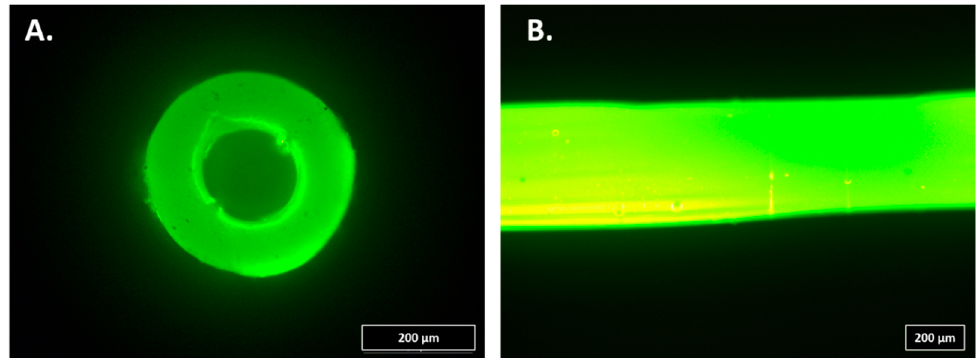
Figure 1. Fluorescence micrographs of a catheter intraluminally ( A ) or extraluminally ( B ) coated with A50 sol-gel. The fluorescence detected is uniquely due to the presence of moxifloxacin trapped by the net of the sol-gel.